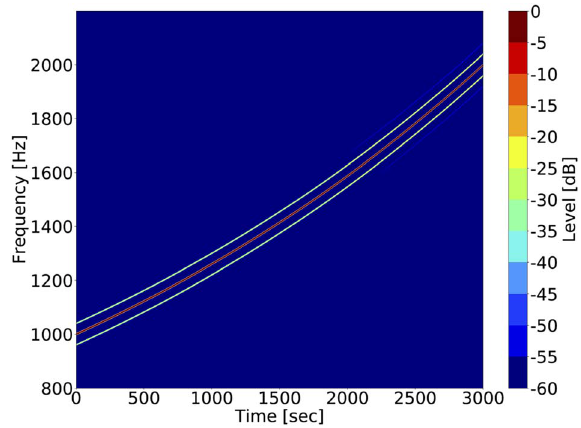
Figure 8. Spectrogram of the output acoustic pressure p ð z ¼ 1 ; t Þ . Intermodulation distortion is observed, increasing with the chirp frequency f 2 ½ f a ; f b (cid:4) .